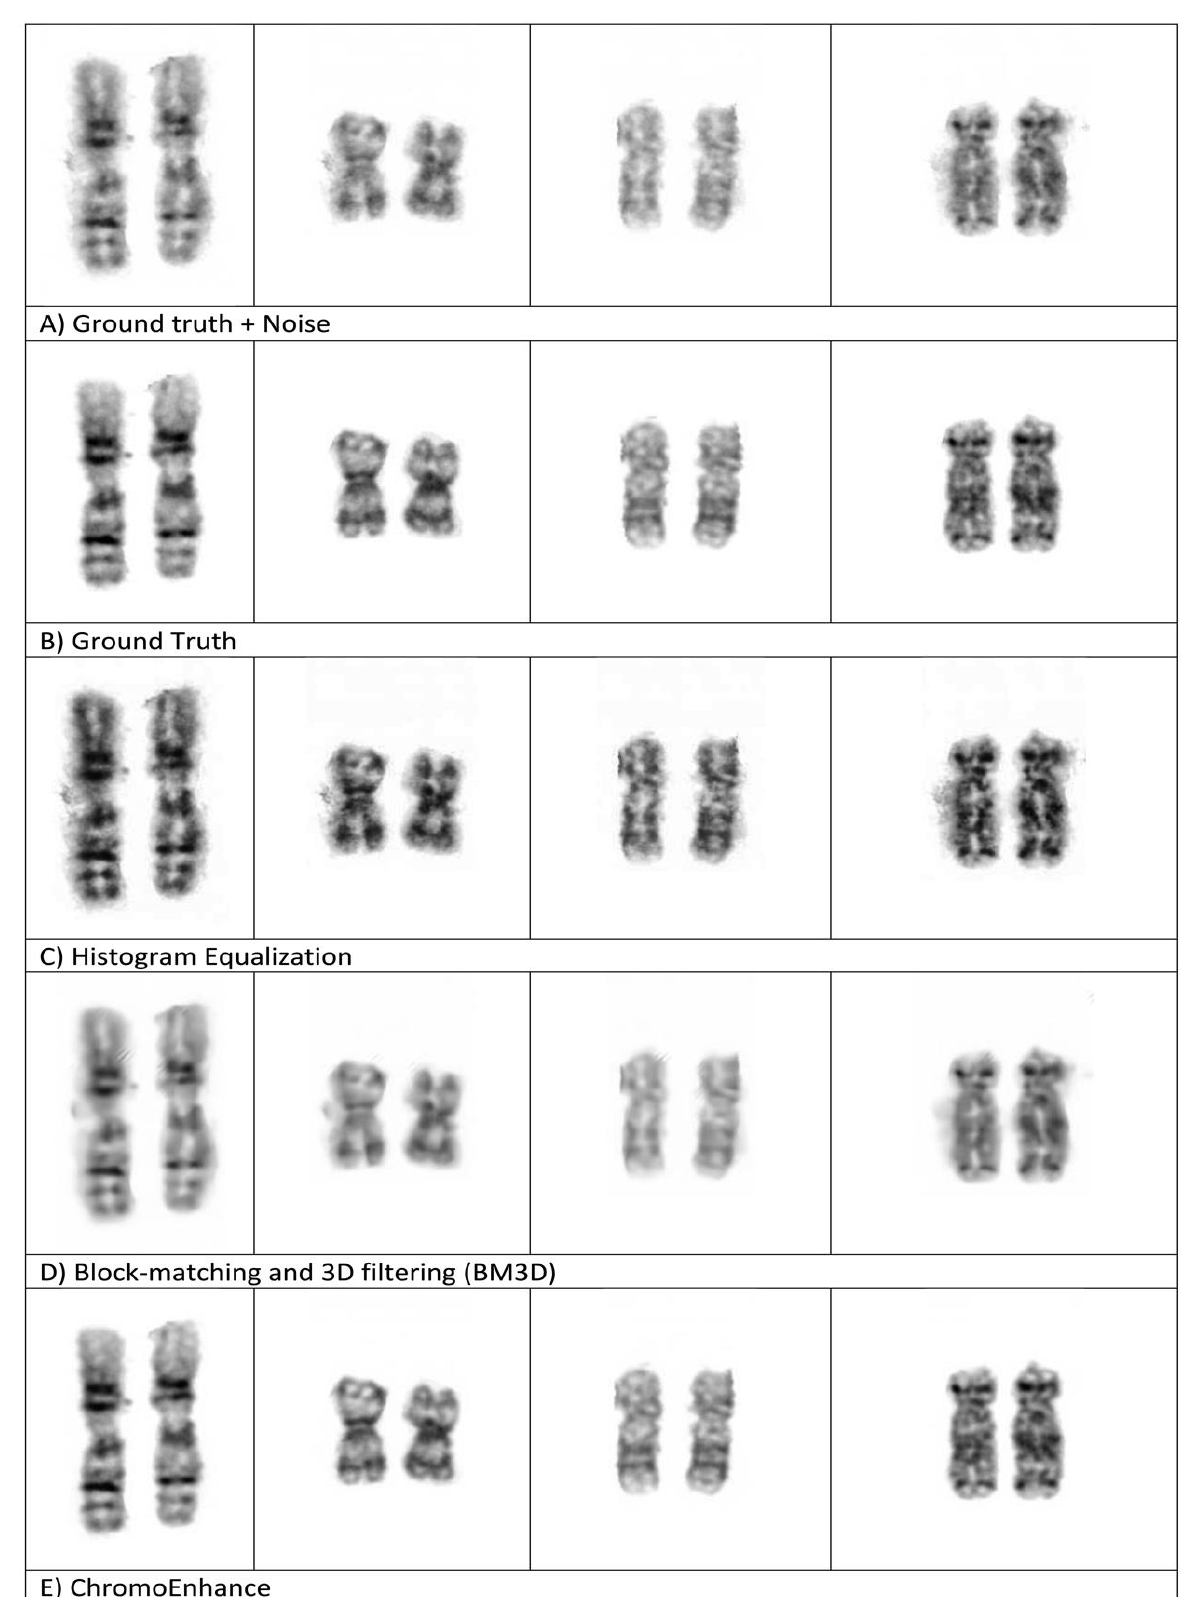
Figure 6. ( A – E ) Comparing different enhancement methods.